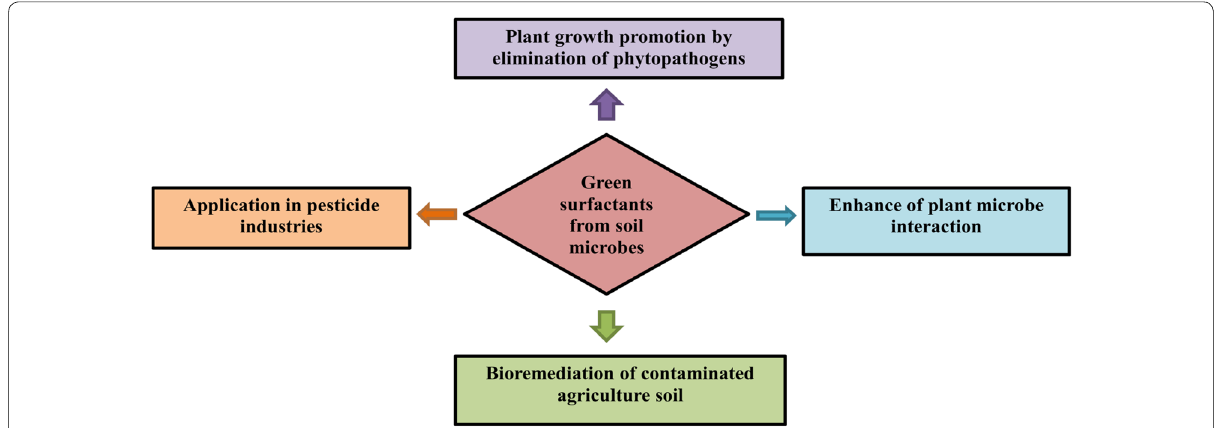
Fig. 3 Multifunctional prospective of biosurfactants in